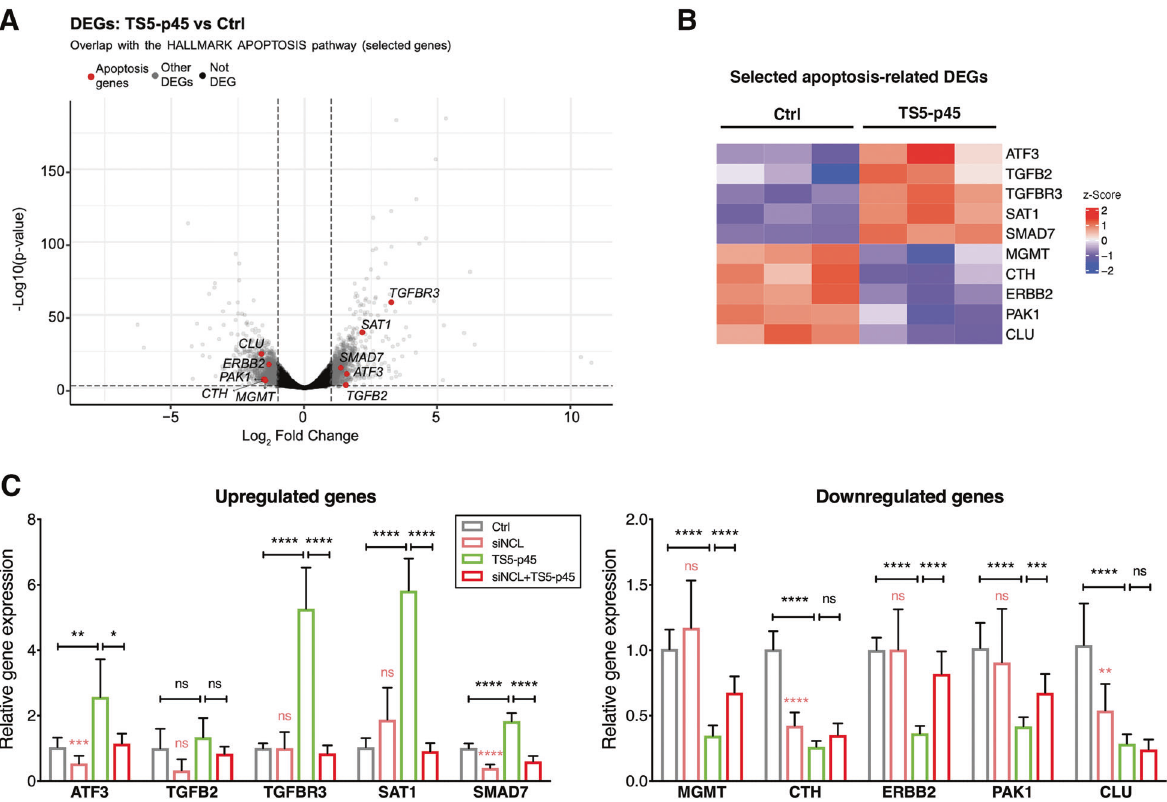
Fig. 7 TS5-p45 alters the expression of apoptosis-related genes in ECs. A RNA-seq revealed DEGs, shown as downregulated genes (log 2 foldchange < − 1) and upregulated genes (log 2 foldchange > 1) with adjusted p -value < 0.05, for TS5-p45 vs Ctrl. DEGs with and without signi fi cance were shown in gray and black, respectively, while selected 10 apoptosis-related DEGs with signi fi cance were highlighted in red. B Gene expression changes of the selected 10 apoptosis-related genes were visualized with heatmap across Ctrl and TS5-p45 samples in triplicates. C qRT-PCR validation experiments for upregulated genes; ATF3 , TGFB2 , TGFBR3 , SAT1 , SMAD7 , and downregulated genes; MGMT , CTH , ERBB2 , PAK1 , and CLU . siNCL-transfected ECs were included for TS5-p45 treatment. Gene expression levels under TS5-p45 and siNCL + TS5-p45 treatments were normalized to those of Ctrl treatment and shown as fold change. Data shown are mean ± SD from three